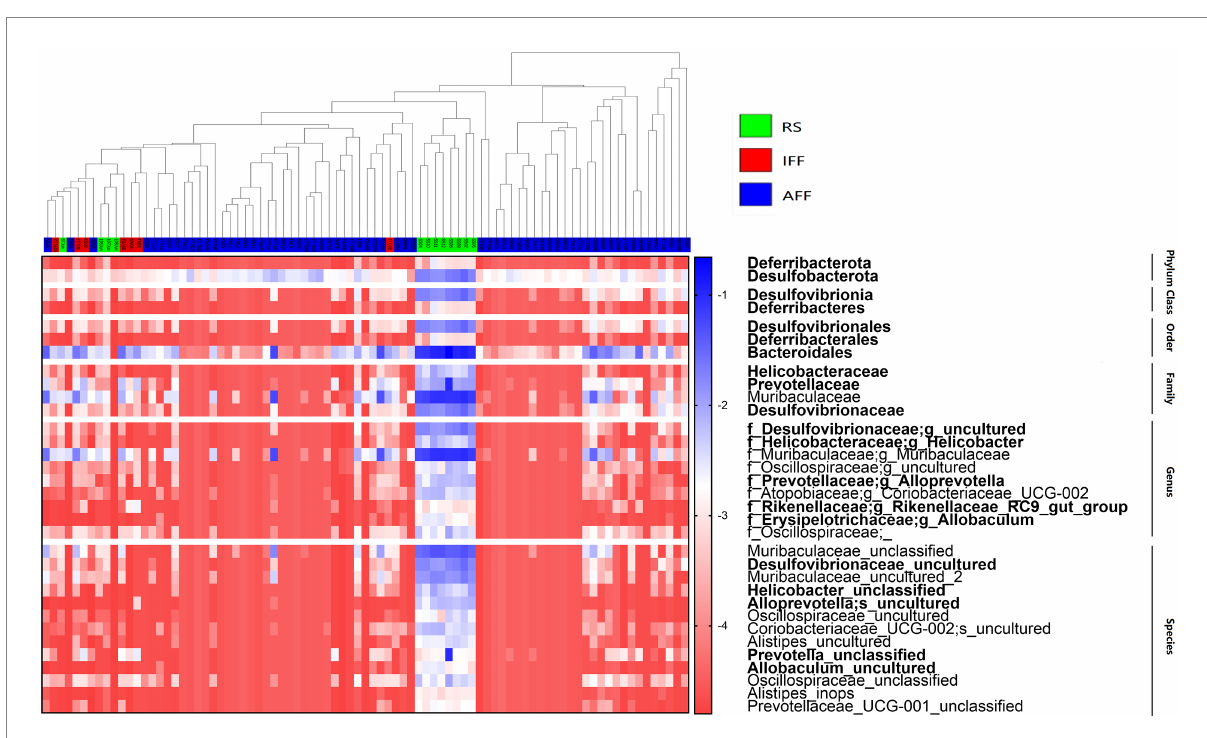
FIGURE 8 Relative abundance heatmap showing the bacterial taxa which were significantly differentially abundant between FF (IFF and AFF) and RS groups as revealed by ANCOM W-values after false discovery rate correction at each taxonomic rank. Color gradient (red to blue) of heatmap plot represents log transformed relative abundance of each taxon (rows) within each sample (columns). Bacterial taxa are bolded if it is classified as a contributor to nitrogen cycle-related KEGG pathways. The samples in the dendrogram was clustered and color-coded to represent FF and RS site groups. AFF, active fish farms; IFF, inactive fish farms; RS, open water reference